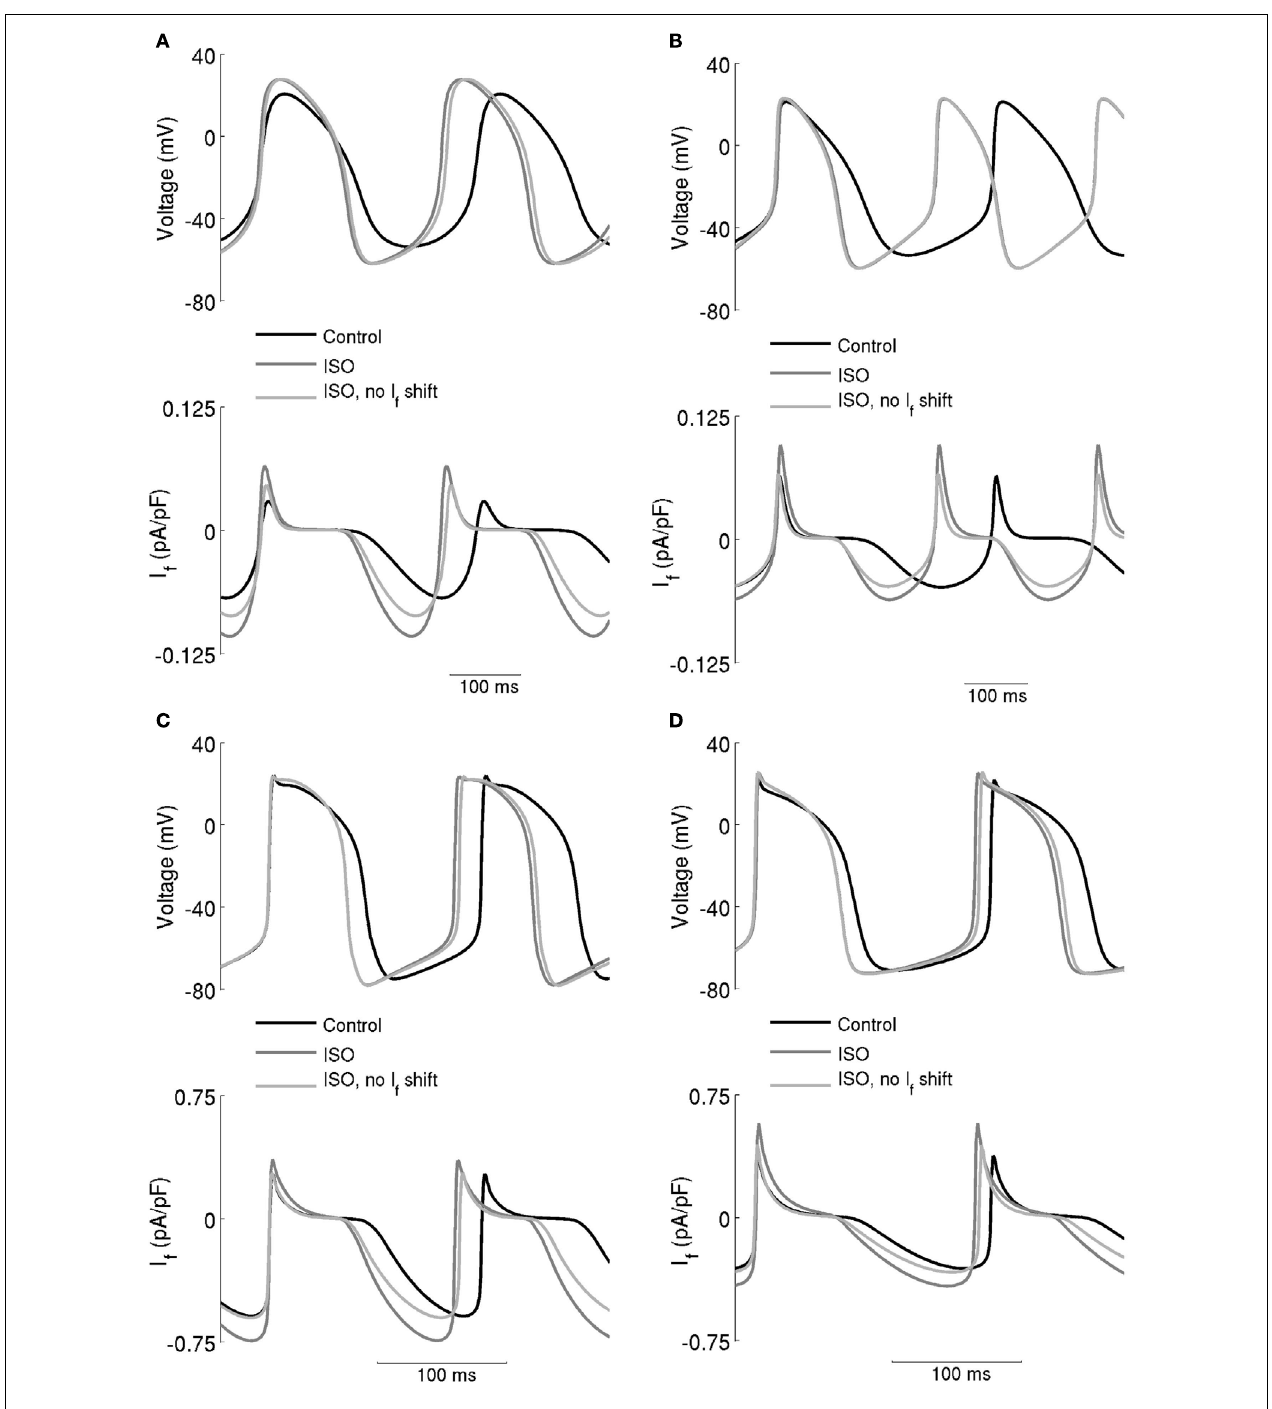
traces) under control conditions and in the presence of 0.05 µ M ISO. Two simulations with ISO are shown – in one, I f was affected and in the other it was not.This shows that the role of I f in the chronotropic effect of ISO is small.